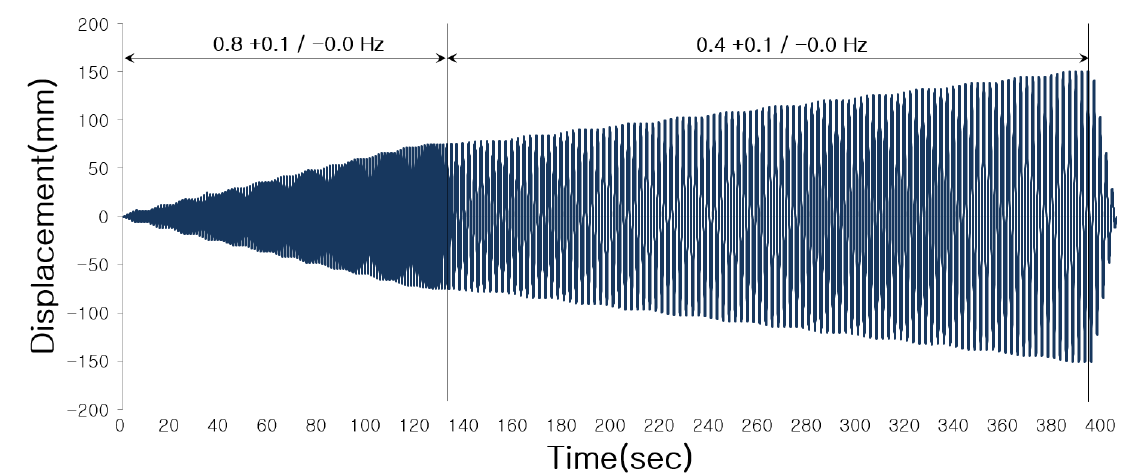
Figure 12. Dynamic seismic waveform applied to the AAMA 501.6 test method. Table 6. Dynamic racking crescendo test results.